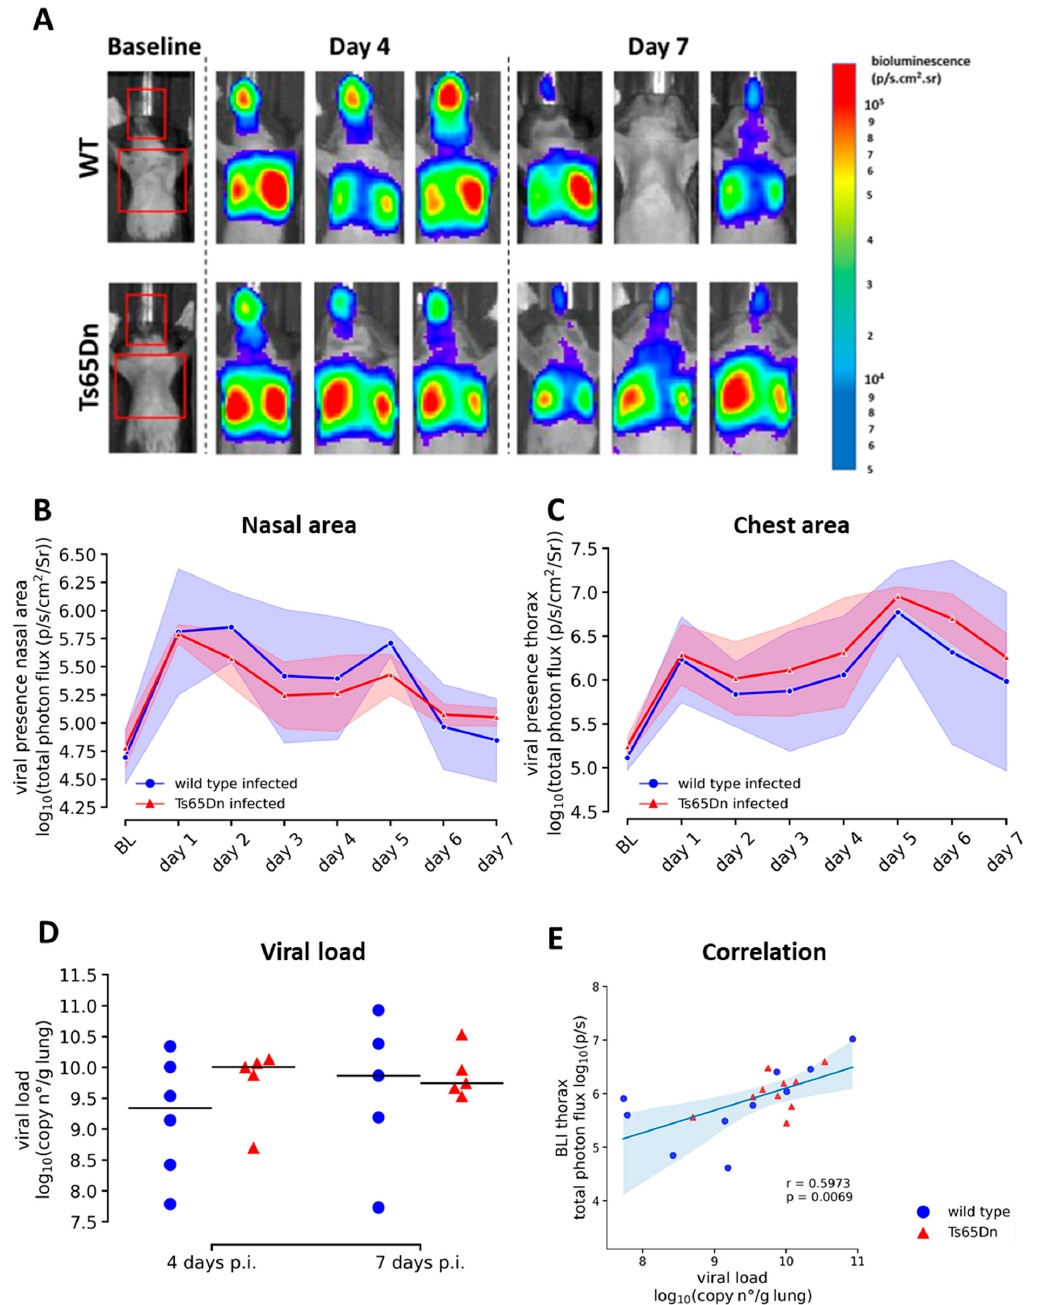
Figure 2. Airway and lung infection upon rhRSV-Luc in wild type and Ts65Dn mice. ( A ). Representative images of the ROI covering the lungs nasal area. Representative BLI images of mice at baseline, four days and seven days post rhRSV-Luc infection. ( B ) Total photon fl ux (log scale) from in vivo BLI based on a ROI covering the nasal area. ( C ) A ROI covering the thorax area of wild type (pooled 4 days infection N = 6 and 7 days infection N = 5) and Ts65Dn (pooled 4 days infection N = 5 and 7 days infection N = 5) mice. Data are shown as mean ± SD at each day. ( D ) Assessment of viral burden using RT-qPCR: graph representing the log10 viral copy number per gram lung tissue in wild type (blue circle) and Ts65Dn (red triangle) mice. Data are expressed as individual values and mean ± SD. ( E ) Correlation between viral load and BLI of the thorax area.